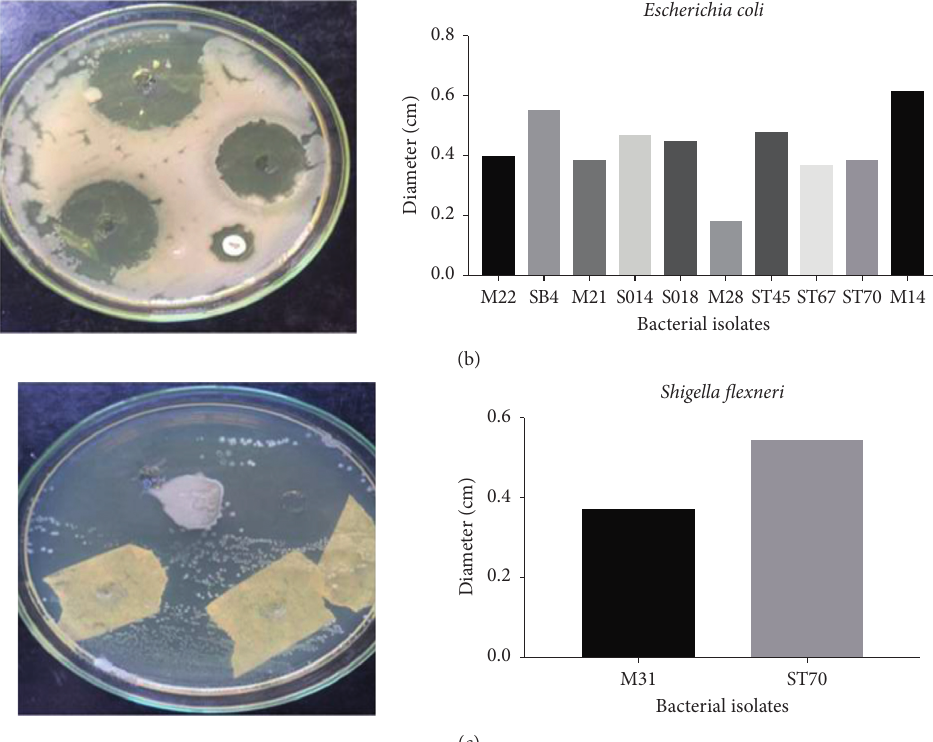
Figure 4: Antimicrobial assay of the biosurfactants against Bacillus cereus (a), Escherichia coli (b), and Shigella flexneri (c).